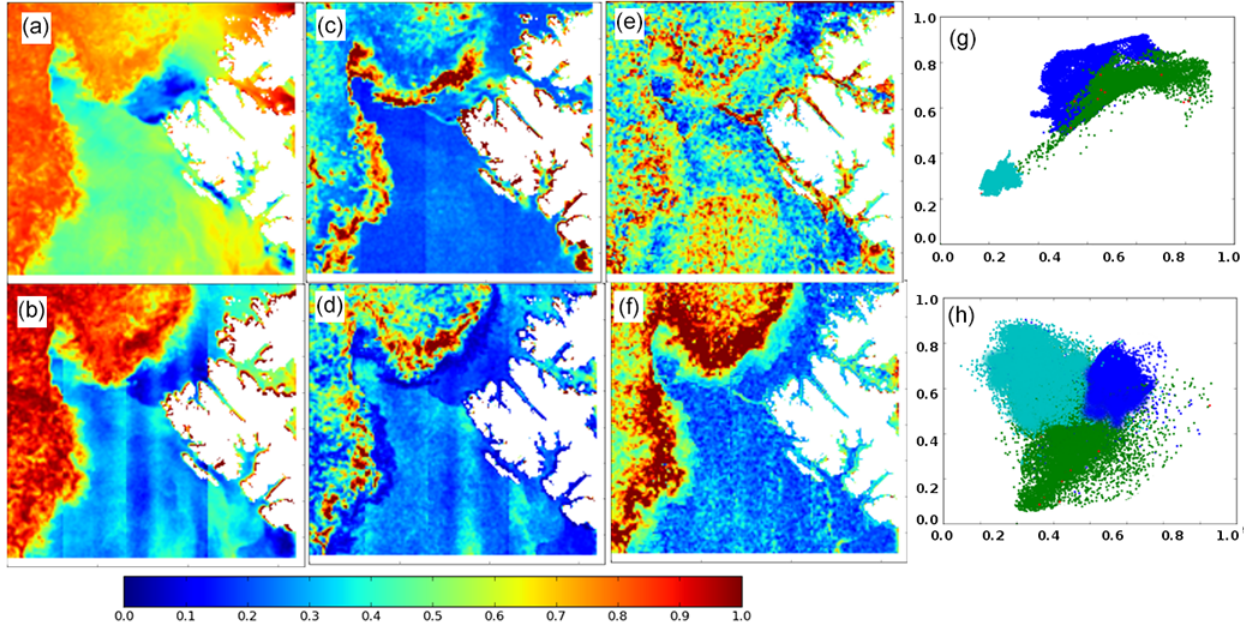
Figure 5. Texture features calculated for RS2 SCW scene, 28 November 2011, in the Fram Strait. (a) Backscatter of HH polariza- tion; (b) backscatter of HV polarization; (c) inertia of HH polarization; (d) energy of HV polarization; (e) correlation of HH polariza- tion; (f) correlation of HV polarization. The scatter plots show how a couple of textural features calculated from RS2 images, shown in Fig. 1, can be used to classify ice (green), rough OW (blue), and calm OW (cyan). (g) σ ◦ of HV vs. σ ◦ of HH. (h) Energy of HH vs. correlation of HV.